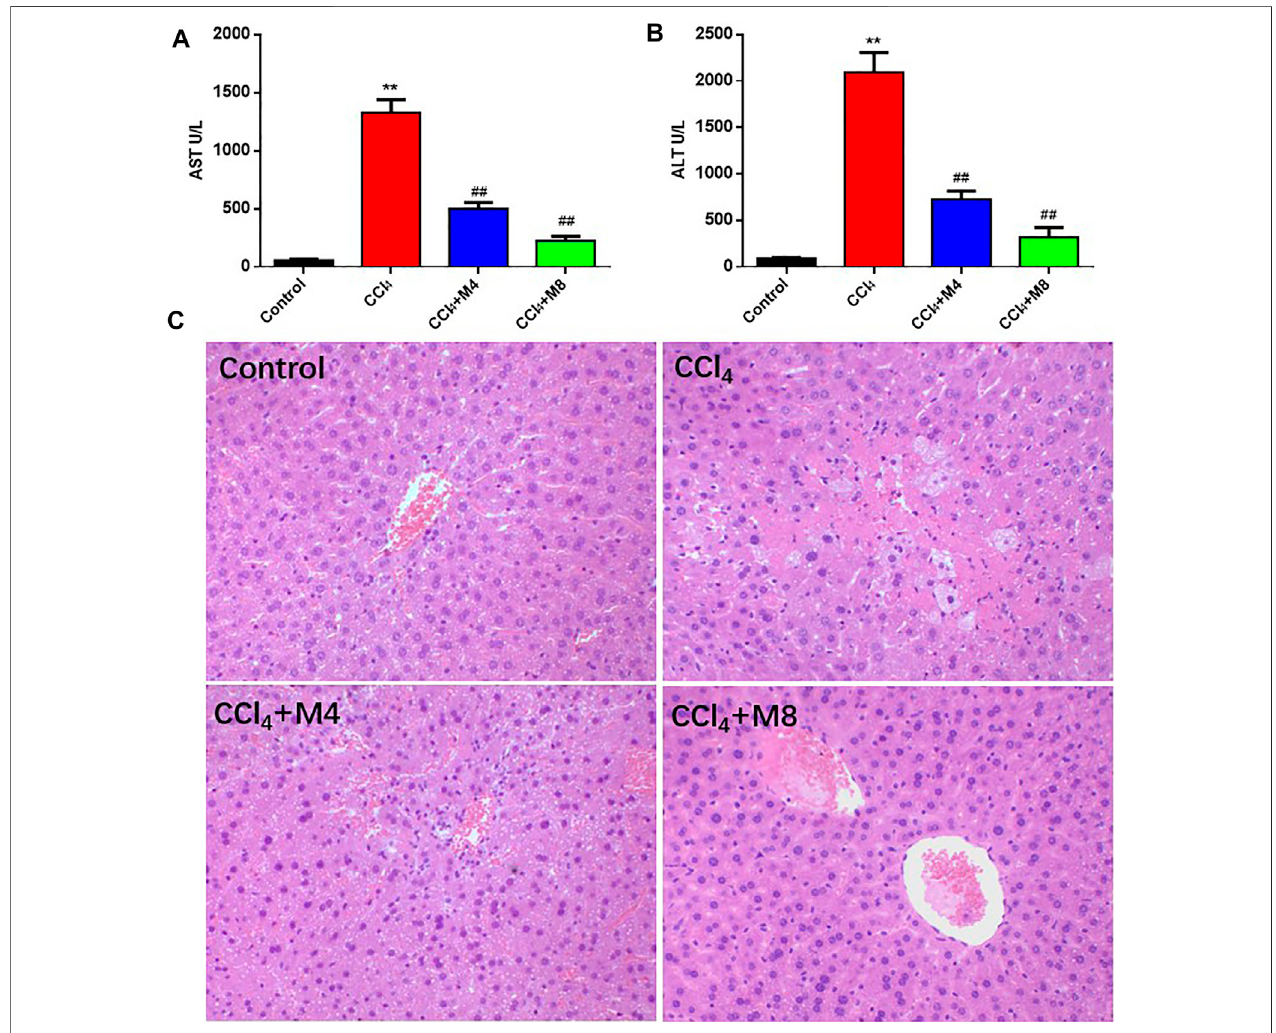
FIGURE 5 | Protective effects of midazolam on CCl 4 -induced hepatic injury in mice. (A , B) The levels of AST and ALT in serum were detected at 24 h after CCl 4 exposure. (C) Pathological images of H&Estainedsections ofliver in control, CCl 4 and CCl 4 plus midazolam treated mice (magni fi cation, ×200). The results were shown as mean ± S.D. ** p < 0.01 vs. the control group; ## p < 0.01 vs. the CCl 4